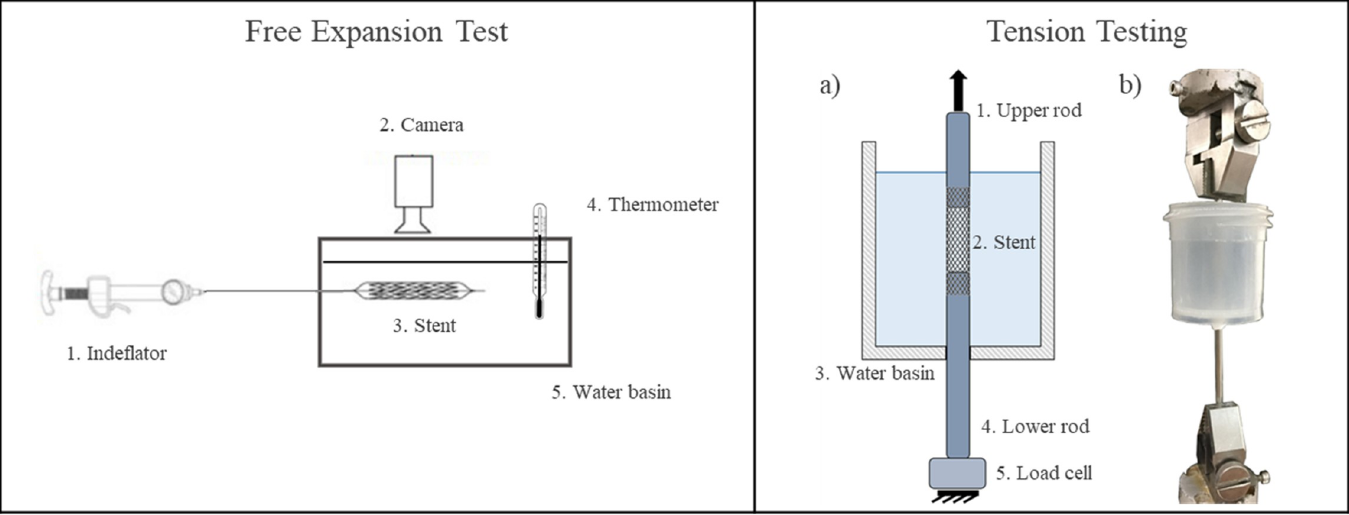
Fig 2. On the left: Schematic representation of the experimental set-up for the free expansion tests. On the right: experimental set-up for the uniaxial tension testing: a) schematic representation, b) image of the actual set-up).